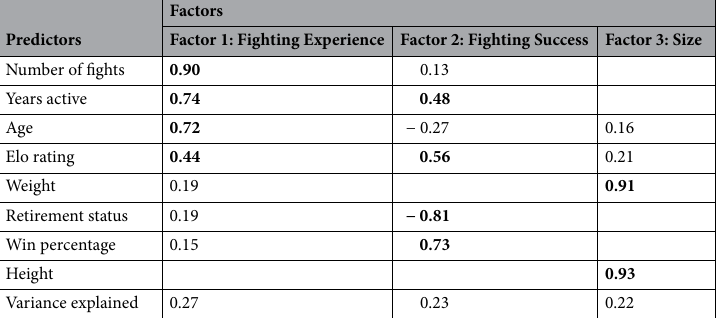
Table 3. Component axis analysis for measures related to fighting ability. Loadings that were above |0.4| are bolded. Factors are named descriptively according to the variables that load most strongly onto them. Empty cells indicate factor loadings